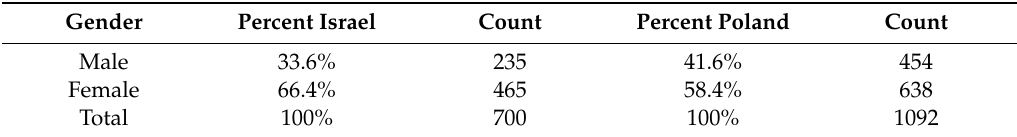
Table 1. Gender of study